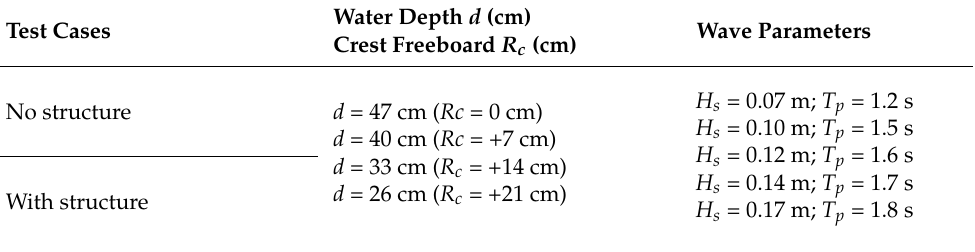
Table 6. Test cases for assessing wave dissipation